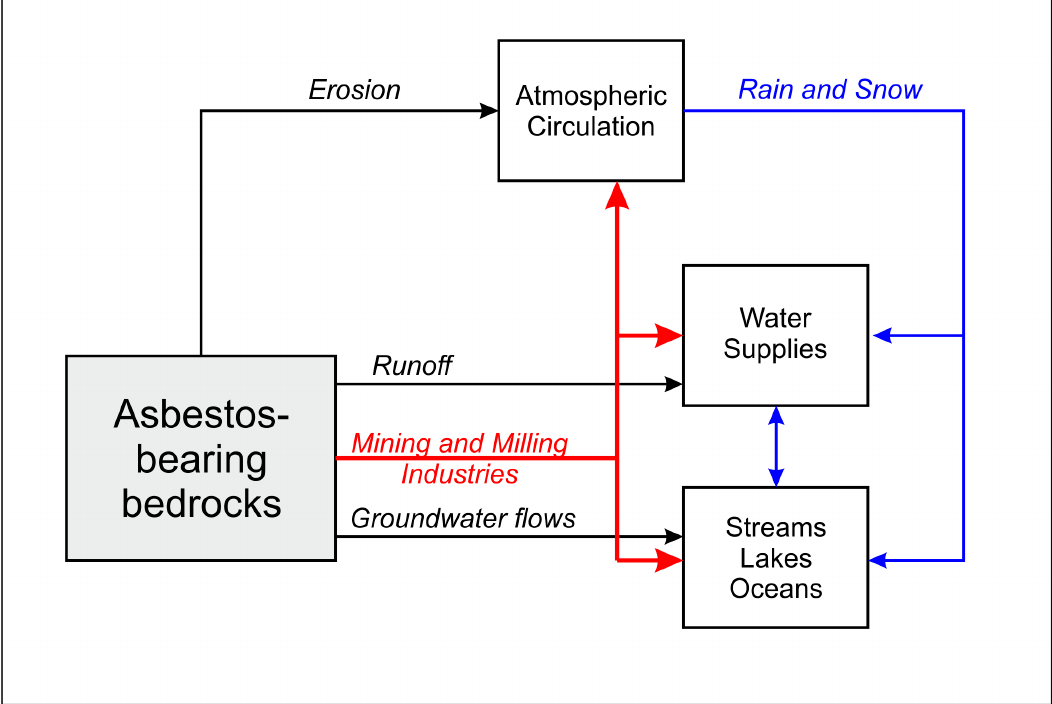
Figure 1. Flowchart illustrating physical/mechanical processes producing asbestos fibres distribution in the environments (modified after [3,11]).